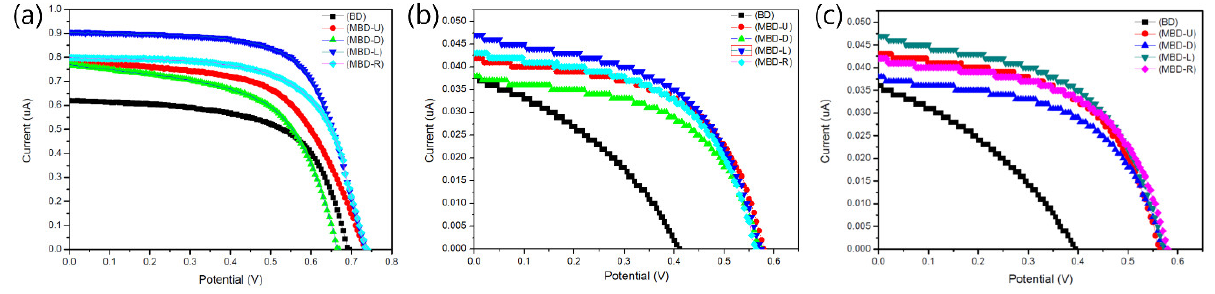
Figure 8. 1% (a), 3% (b), and 5% (c) BiFeO 3 -TiO 2 DSSCs I-V Curves. Table 2. Sample efficiency comparison data before and after magnetization (U-up, D-down, L-left, R-right).